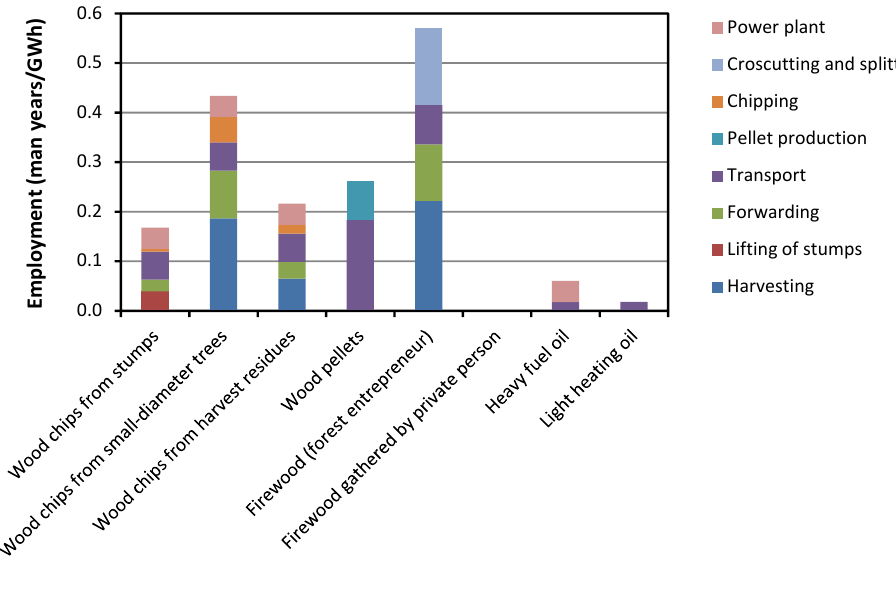
eq./MWh) from machinery used in wood chip, 2